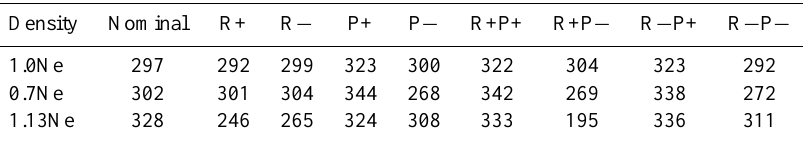
Table 1. Expected median heights of Hankasalmi echoes for a number of electron density distributions that are modifications of the one shown in Fig. 3. Density